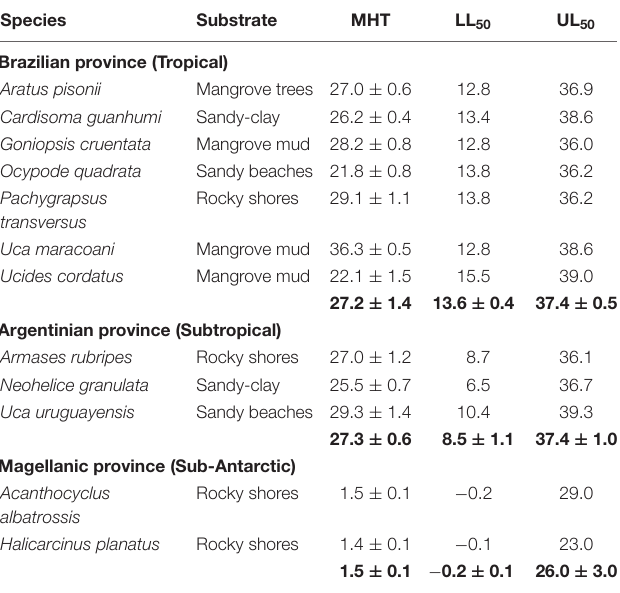
TABLE 1 | Crab species collected from different zoogeographical provinces along the eastern Atlantic coast of South America, providing their microhabitat temperatures (MHT) and lower (LL 50 ) and upper (UL 50 ) critical thermal limits (all in ◦ C) (modified from Faria et al., 2017). Species